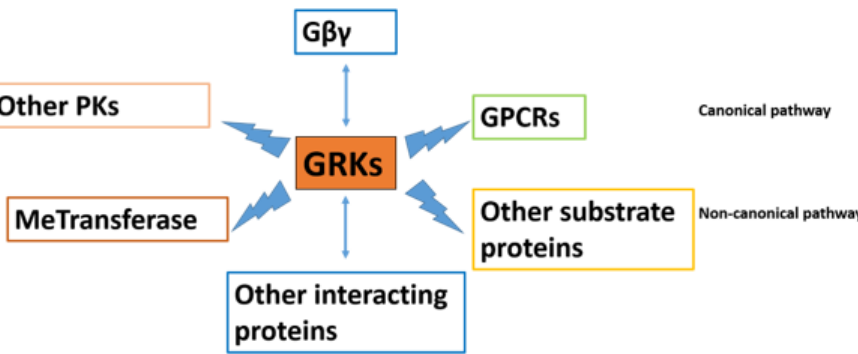
Figure 1. The complex G protein-coupled receptor kinases (GRKs) reactome. GRKs regulate diverse signaling pathways by interaction with proteins. GRKs interact with GPCRs in a canonical pathway. In addition, evidence has suggested that GRKs modulate signaling by interacting with other protein substrates in a non-canonical manner. They have a regulatory function with G β γ subunits, other interacting proteins, MeTransferase, and other protein kinases (PKs).